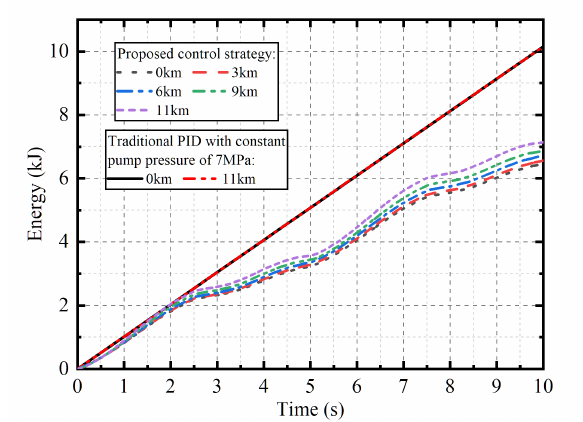
Figure 14. Pump pressure of harmonic movement.